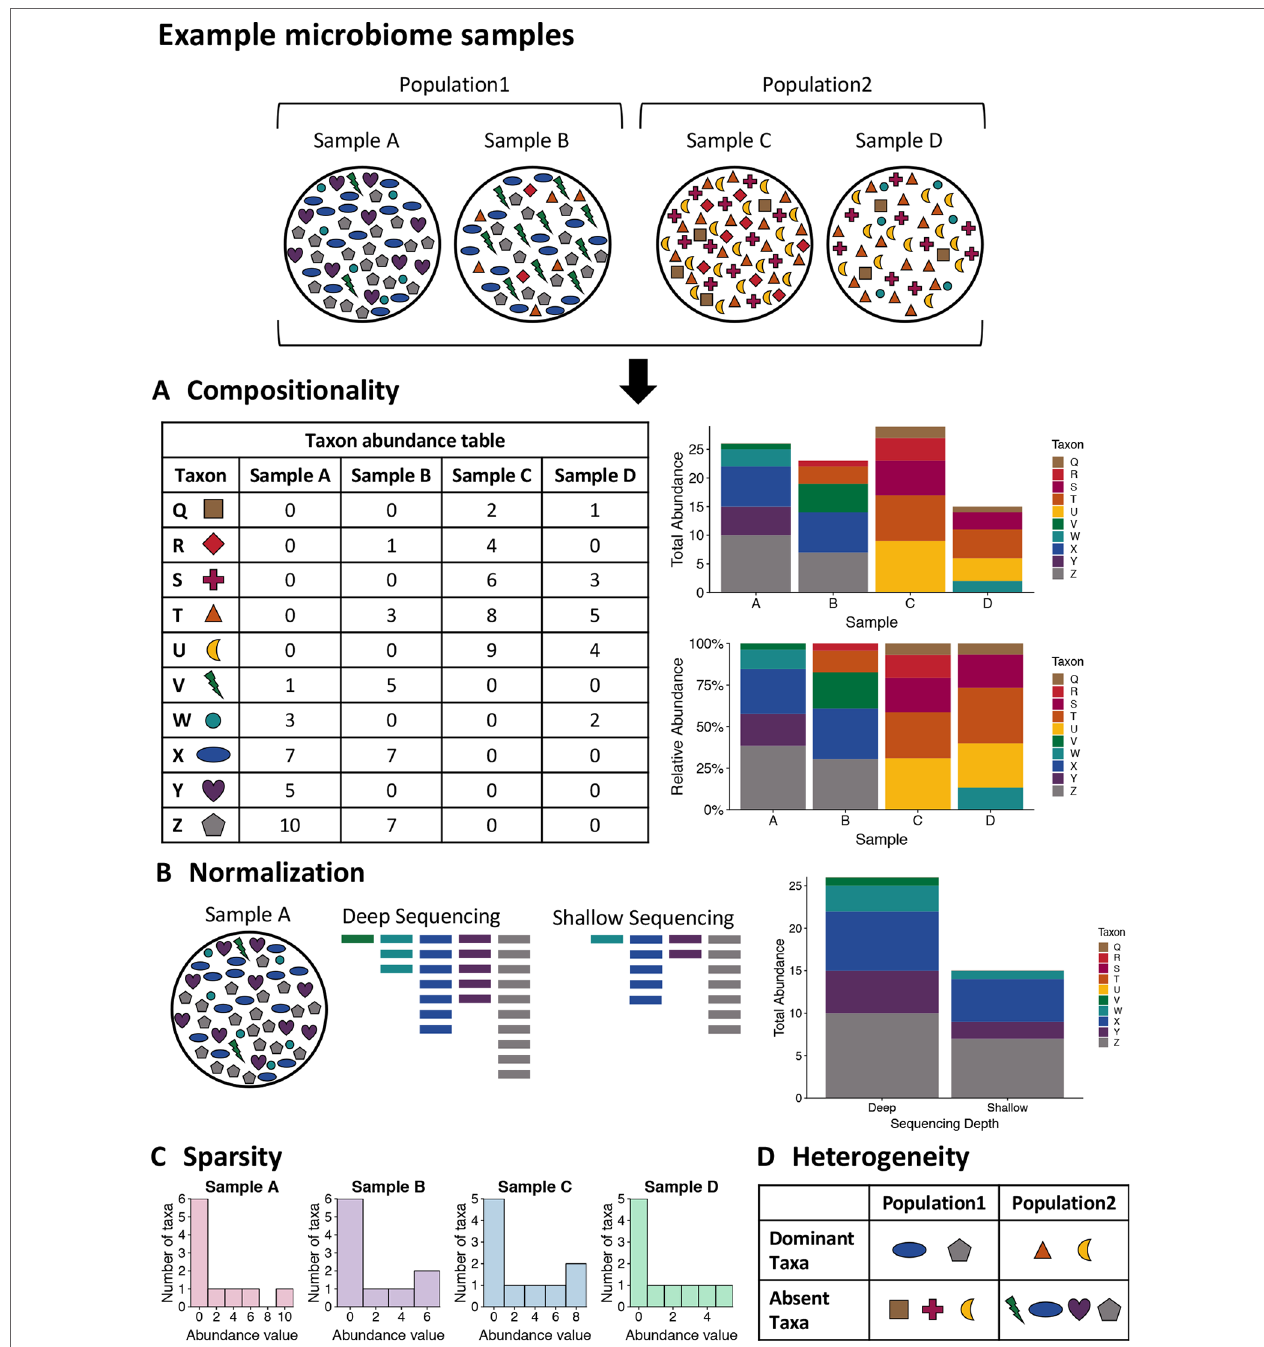
FIGURe 1 | Visualizing the unique challenges of microbiome data. A mock set of bacterial samples from two populations where each colored shape is a bacterial taxon. (A) Compositionality. The taxon abundance table depicts the count of each observed taxon in each sample. When sequencing microbiome samples, the resulting counts of taxa are not representative of the actual taxa counts in the sample due to constraints of sequencing. Due to this, relative abundances are generally used in analysis of microbiome data. The bar plots illustrate the difference in community representation between raw counts (top) and relative abundances (bottom). (B) Normalization. Due to the constraints of sequencing, the overall sequencing depth of a sample can impact the results. For example, shallow sequencing may miss rare taxa such as the green taxon V in the example sample A that is present in low abundance in the community. (C) Sparsity. Microbiome data are often very sparse, where most observations are zero. This is illustrated by the histogram of taxa counts for each sample where most counts are zero and there are few taxa with high counts. This can also be seen in the table for part A, where many entries are zero. (D) Heterogeneity. The table summarizes the taxonomic heterogeneity in the mock dataset between the two populations. Each sample has a unique taxonomic composition, but there are also population specific signatures. The samples in each population are dominated by a few taxa, and these dominant taxa are different for the two populations. Additionally, there are taxa that are highly abundant in one sample and absent from the rest, such as the purple taxon Y in sample A.